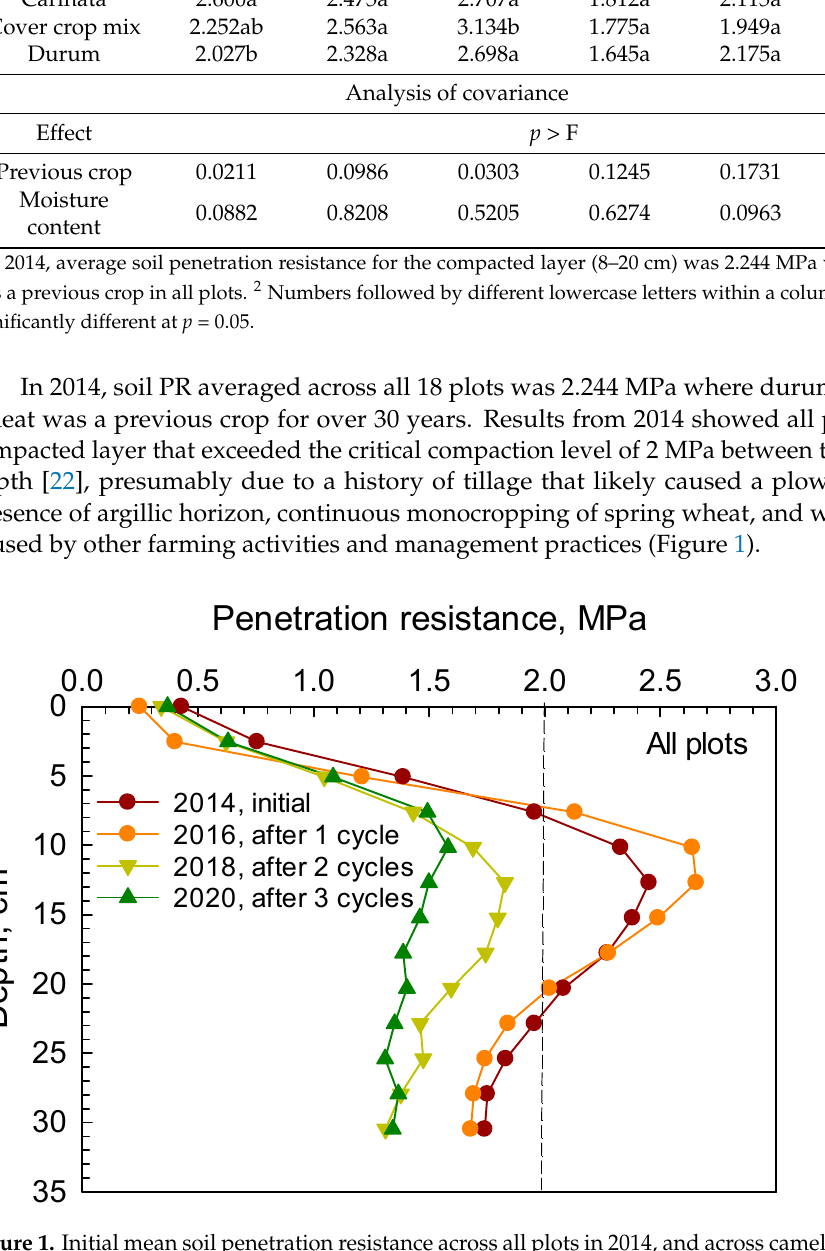
Figure 2. Initial mean soil penetration resistance across all plots in 2014 and after 1 cycle in 2016, after 2 cycles in 2018, and after 3 cycles in 2020 for camelina as a previous crop.